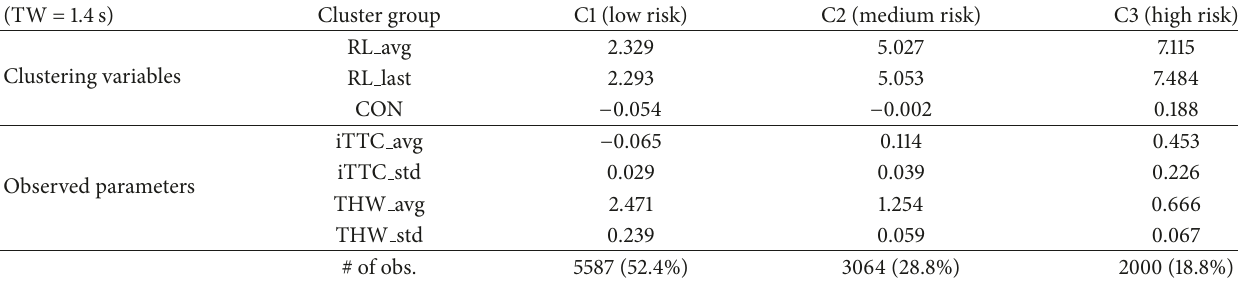
Table 5: Characteristics of TW-based driving risk state clusters.